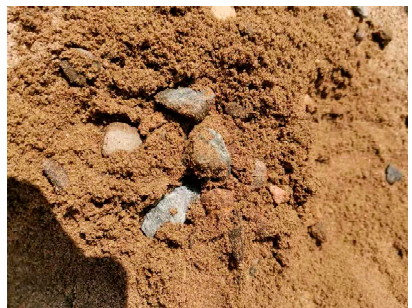
Figure 3. Model soil.